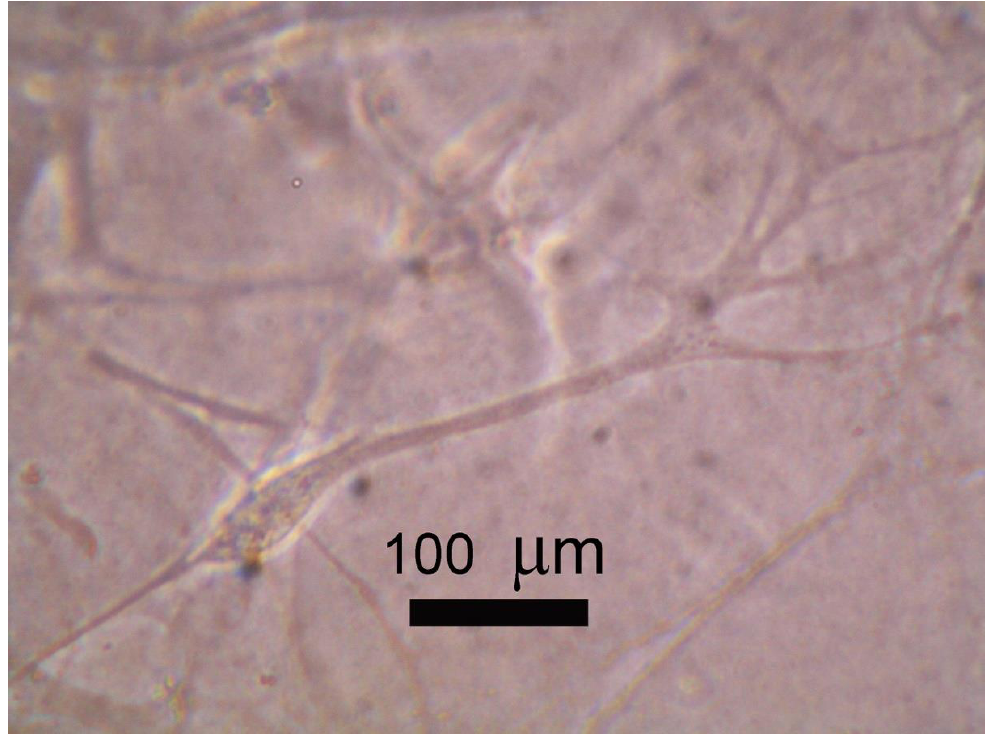
Figure 3. ADSCs on ultra-soft hydrogel: ADSCs cultured on photocurable hydrogel for 21 days adopted a neural-like morphology induced by matrix elasticity which happens via material-mediated mechanotransduction.